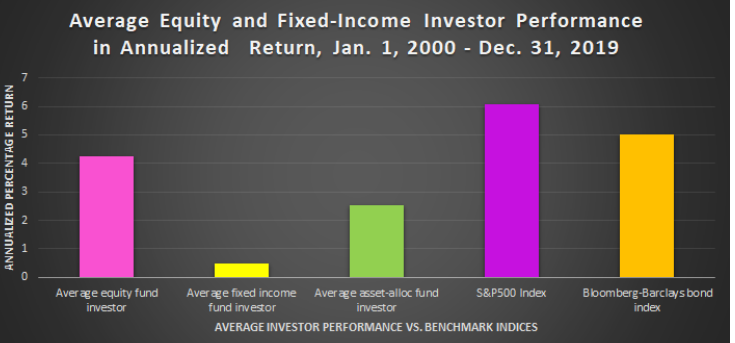
Figure 3. Twenty-year return for the average investor in various investment types, against stock/bond benchmarks, based on research by Dalbar, Inc., as reported in (Fidelity 2021). Note that even the performance of the benchmark S&P500 index was muted in this period, as it contained both the 2000 Dotcom crash and the 2008 financial crisis